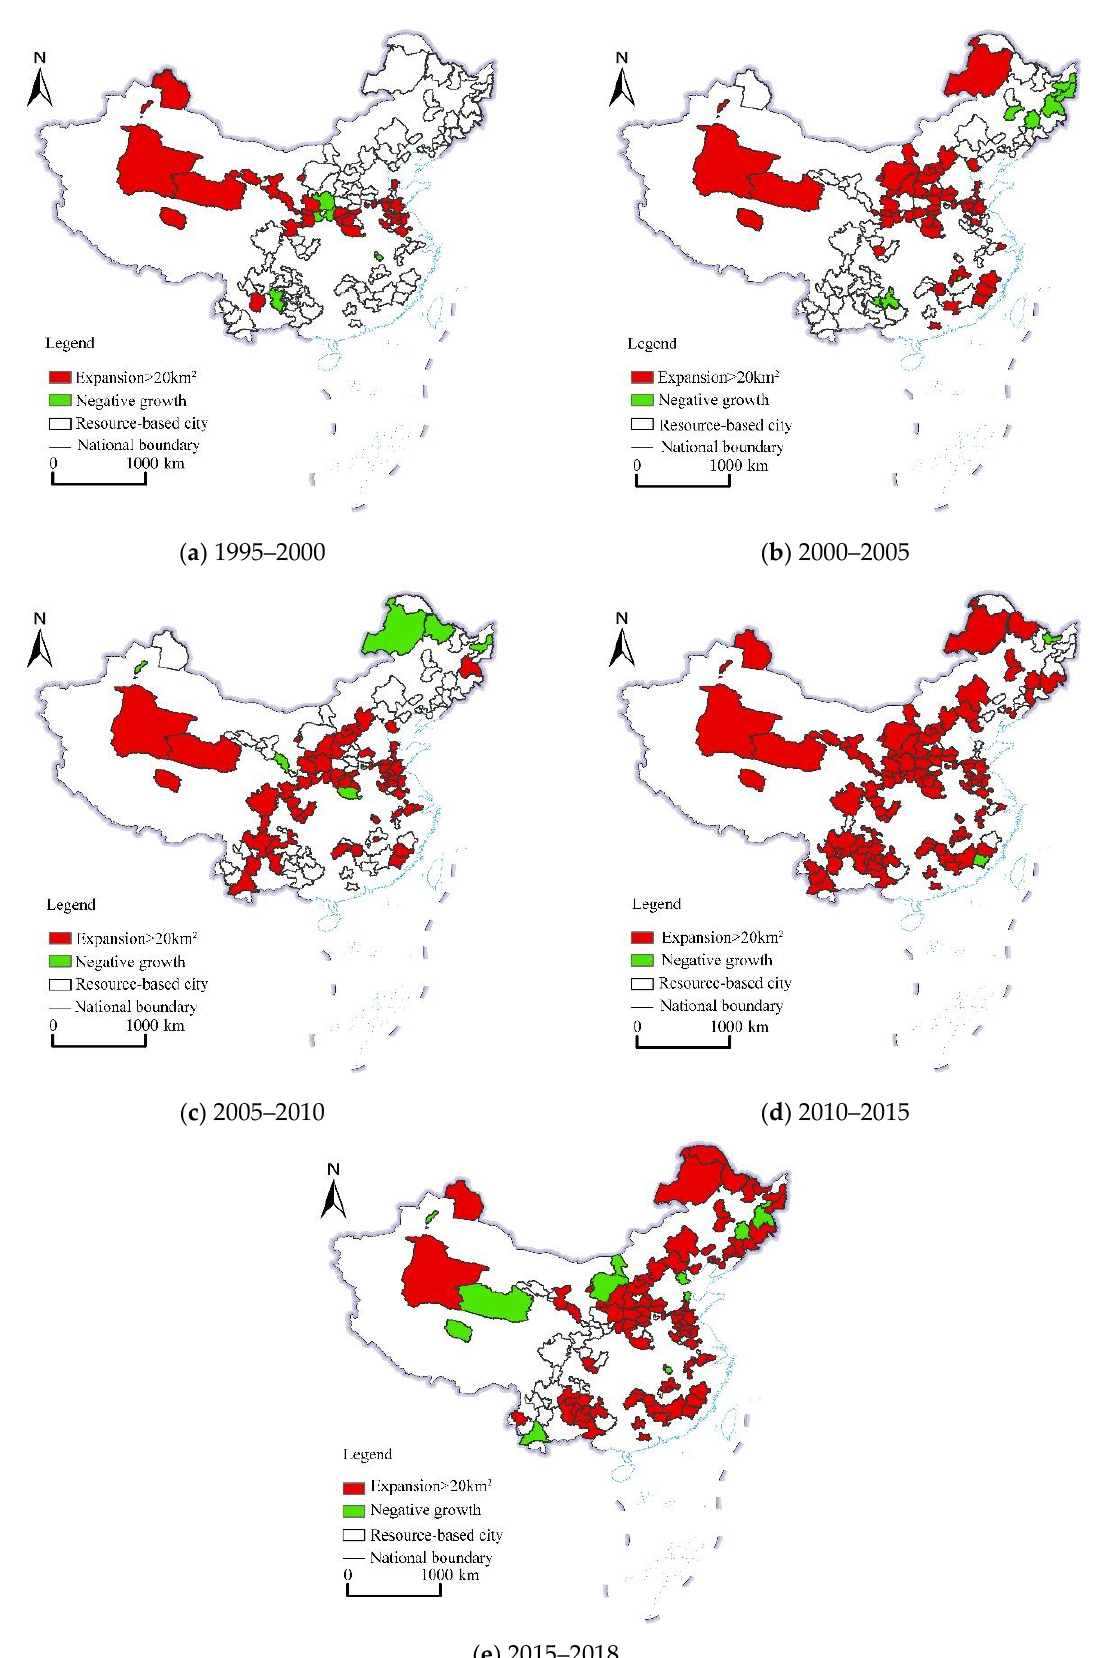
Figure 4. Spatial pattern of construction land change in RBCs (1995 – 2018).